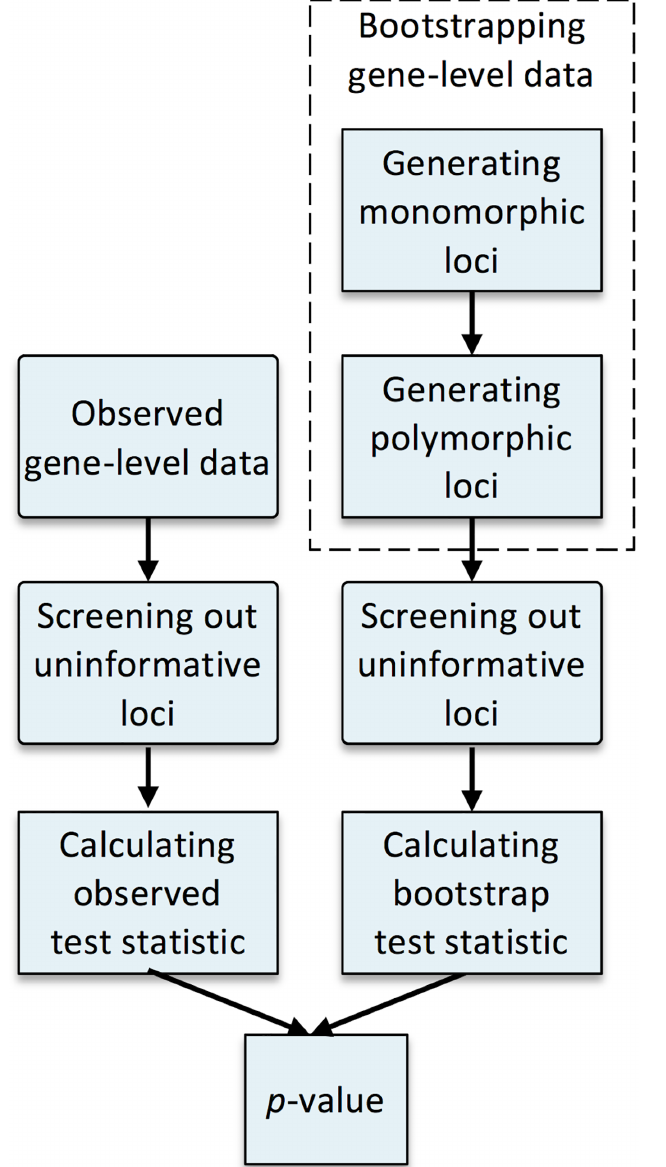
Fig 1. Flowchart of the proposed